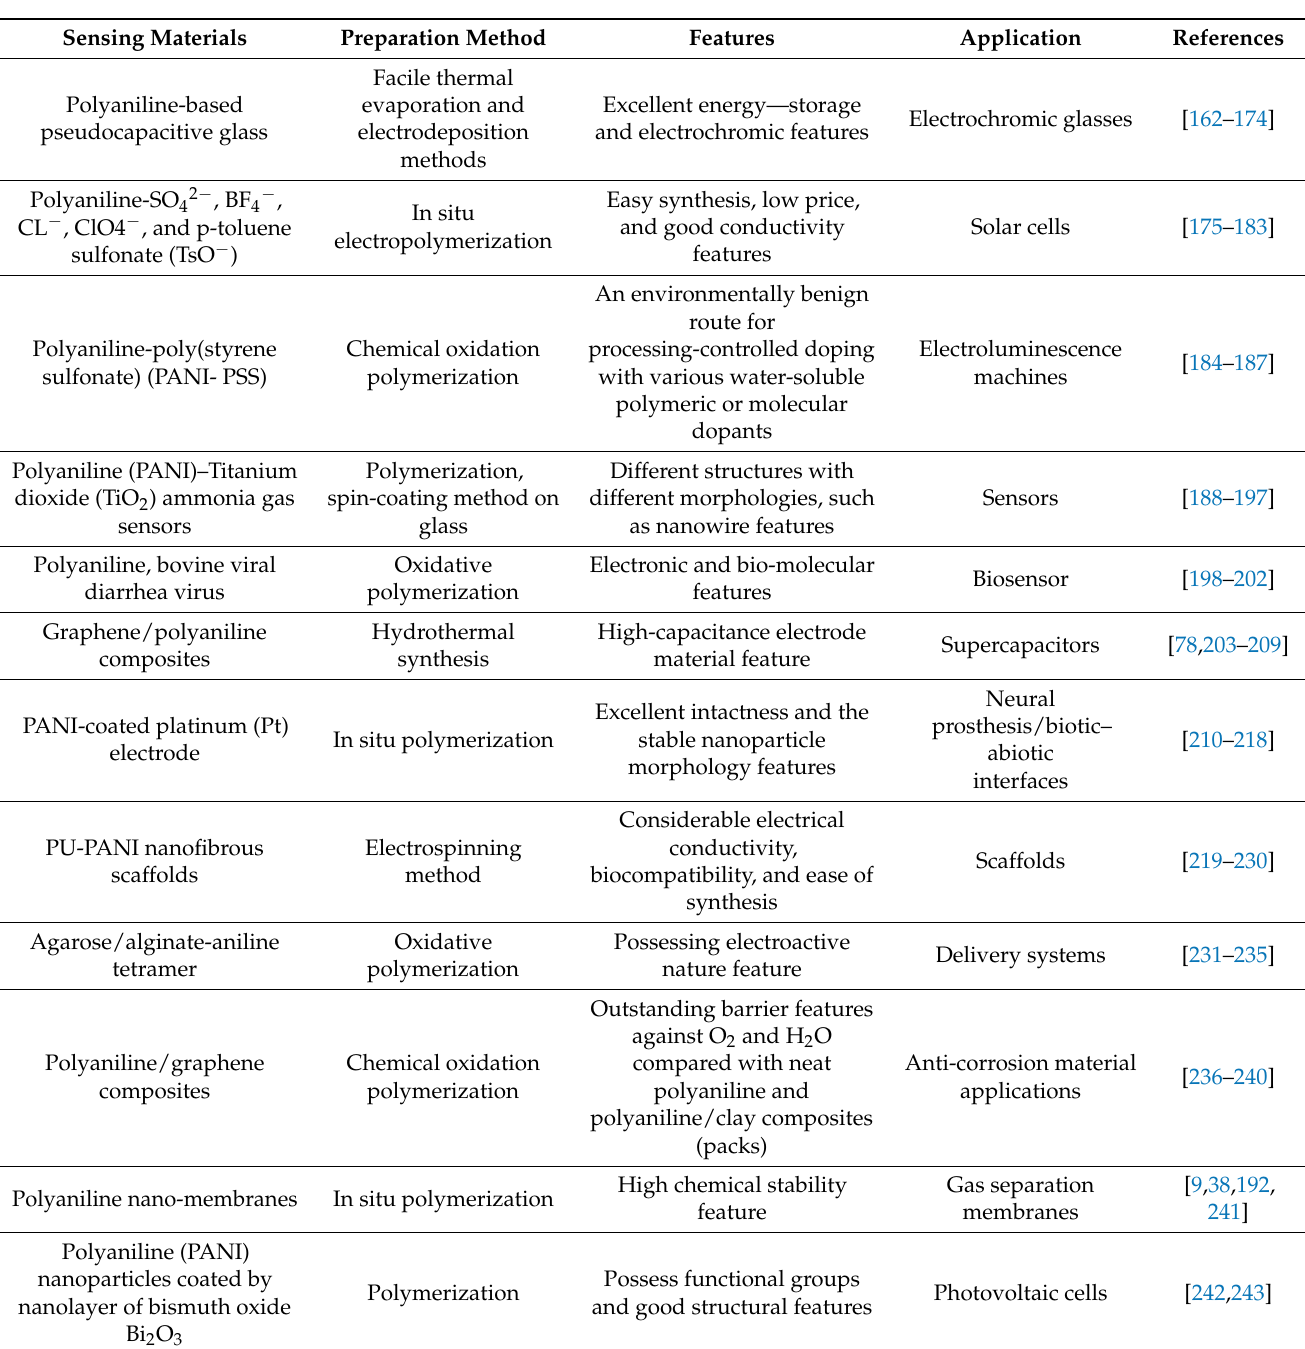
Table 2. PANI nanocomposites used in several